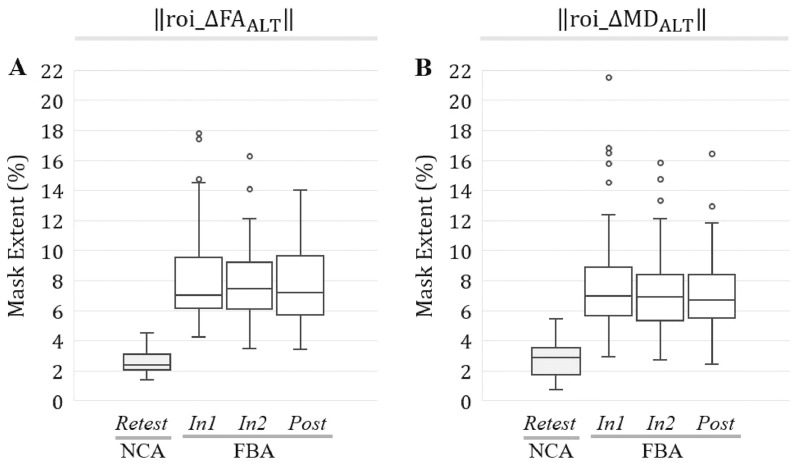
At all follow-up sessions, football athletes (FBA) exhibited significantly (p < 0.001) greater spatial extents of substantial changes in FA and MD, in ROIALT, than did noncollision athletes (NCA). Box-and-whisker plots are presented at each follow-up session for (A) ‖roi_ΔFAALT,j,i‖; (B) ‖roi_ΔMDALT,j,i‖.